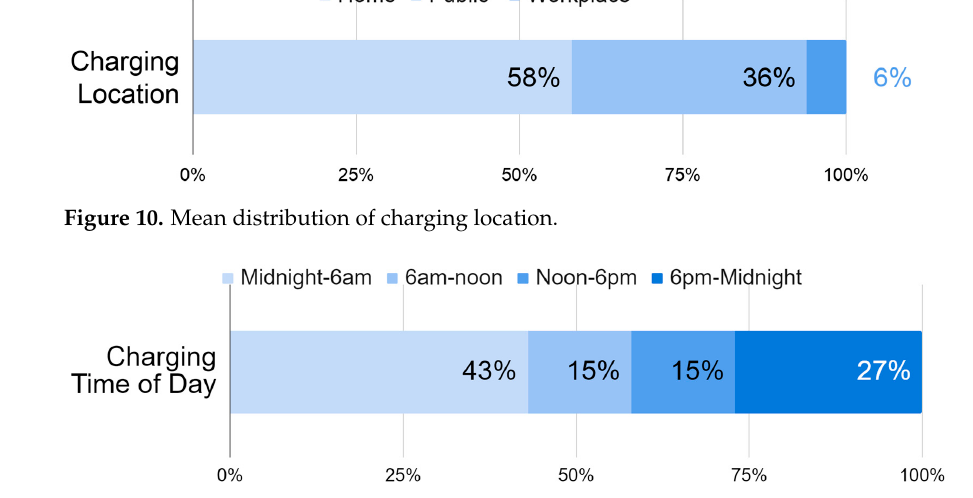
Figure 11. Mean distribution of charging time of day.